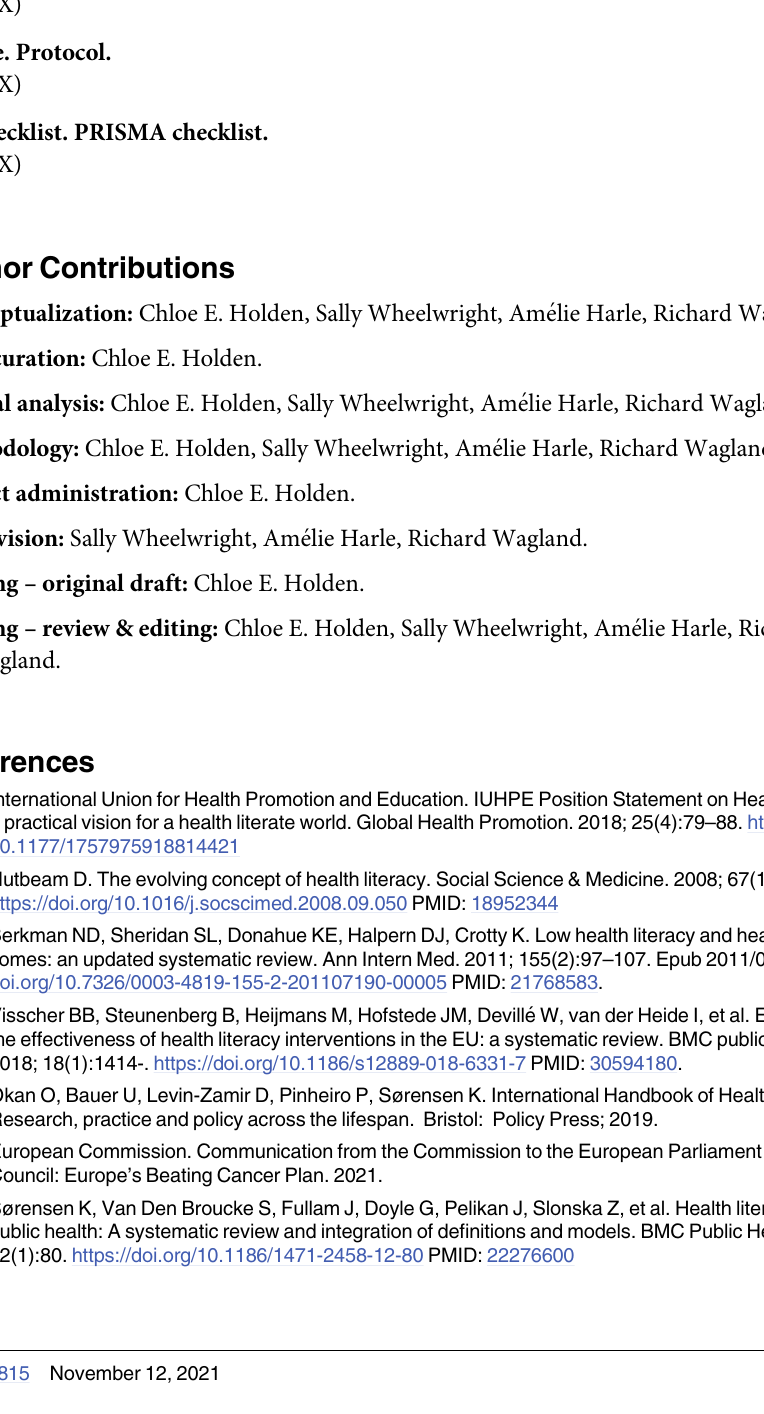
S1 Table. Supplementary data on included papers reporting associations with health